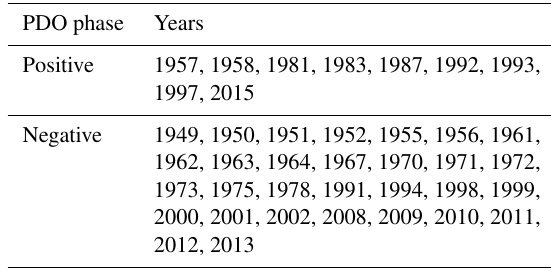
Table 1. Selected PDO years in this